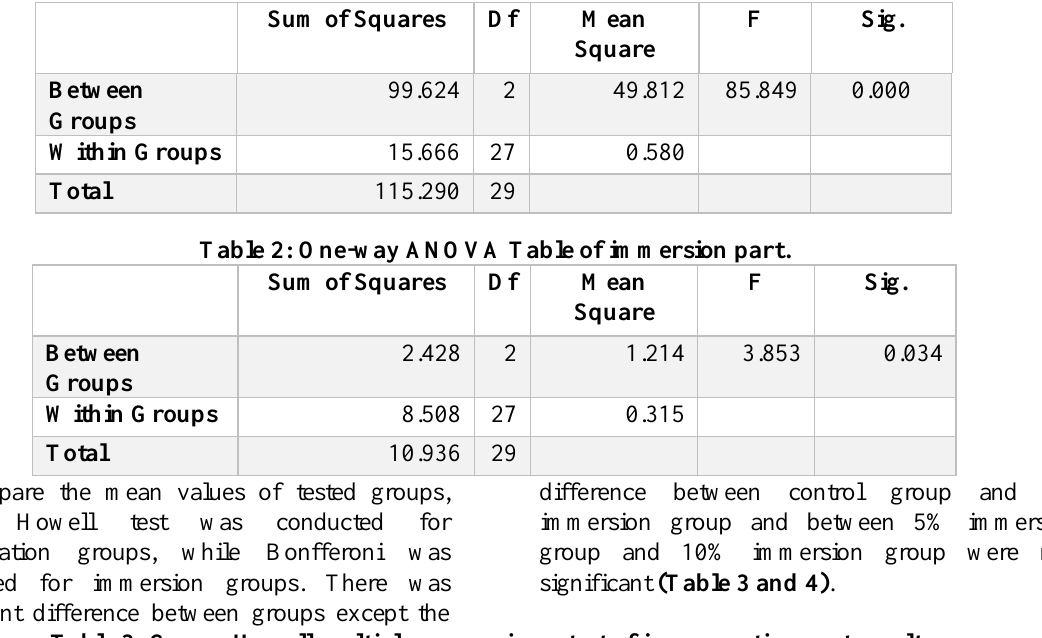
Table 2: One-way ANOVA Table of immersion part.